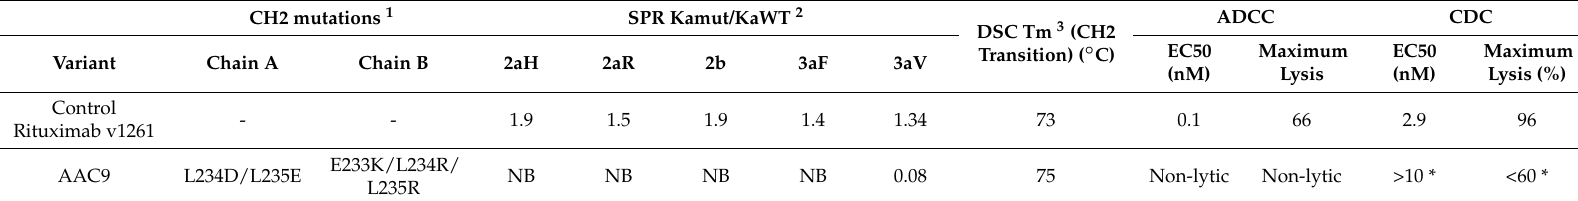
Table 2. Fc γ R binding, thermal stability and ADCC/CDC activity of the lead Asymmetric Antibody Construct as an anti-CD20 Rituximab